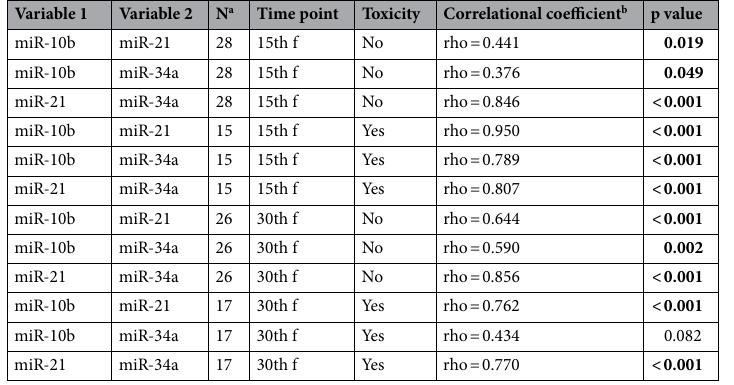
Table 4. Correlations among miRNA-10b/21/34a expression levels. a N-number of patients. b Correlation coefficient. p values equal or less than 0.05 are significant